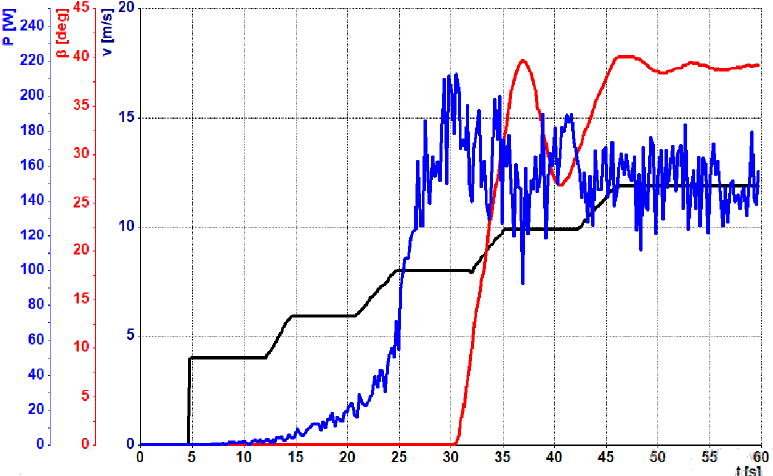
Figure 5. Wind speed, active power, and blade angle of first experimental case study.